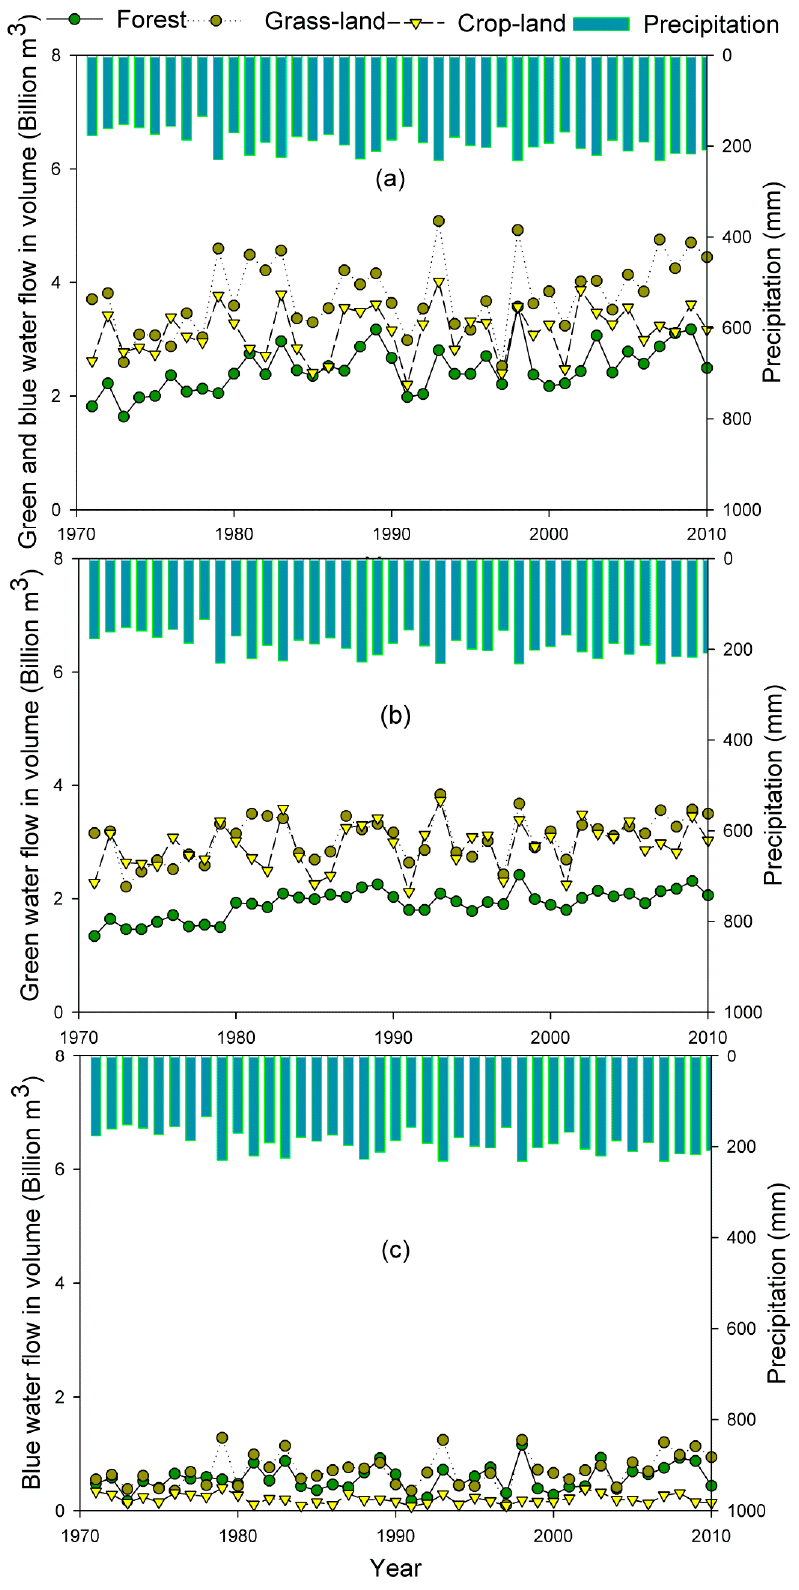
Figure 4. Green and blue water flow in terms of volume of the typical ecosystem. ( a ) is green and blue water flow in volume, ( b ) is green water flow in volume, ( c ) is blue water flow in